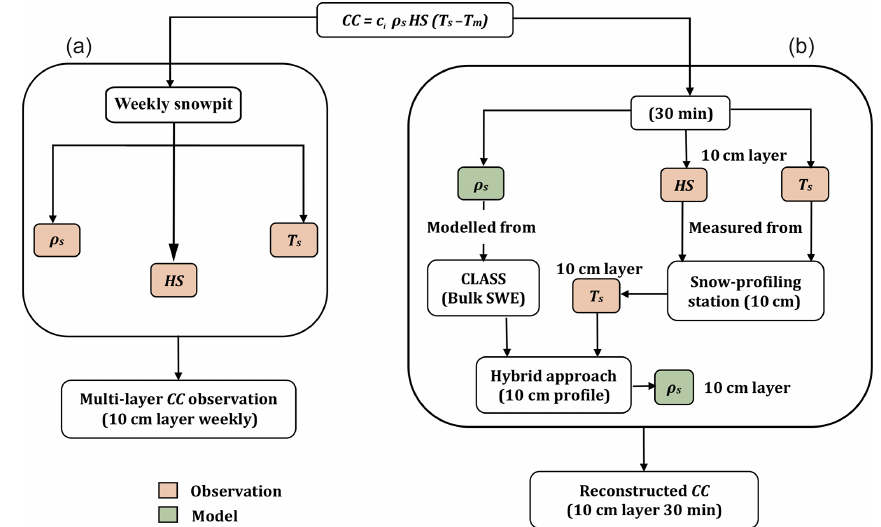
Figure 2. Schematic representation of the methodology adopted in this study. The left column describes the acquisition of CC from weekly snowpits, while the right column describes the construction of continuous CC data every 30min using an approach combining observations (orange cells) and modelling (green cells). ρ s stands for snow density, HS for snow height, and T s for snow temperature. Table 2. Local availability of meteorological forcing data for use in CLASS simulations. Precipitation data are from Environment and Climate Change Canada (ECCC), weather station 7042388, located 4km north of the BEREV. Sites Inputs Sap1 Juv1 Mat1 Mat2